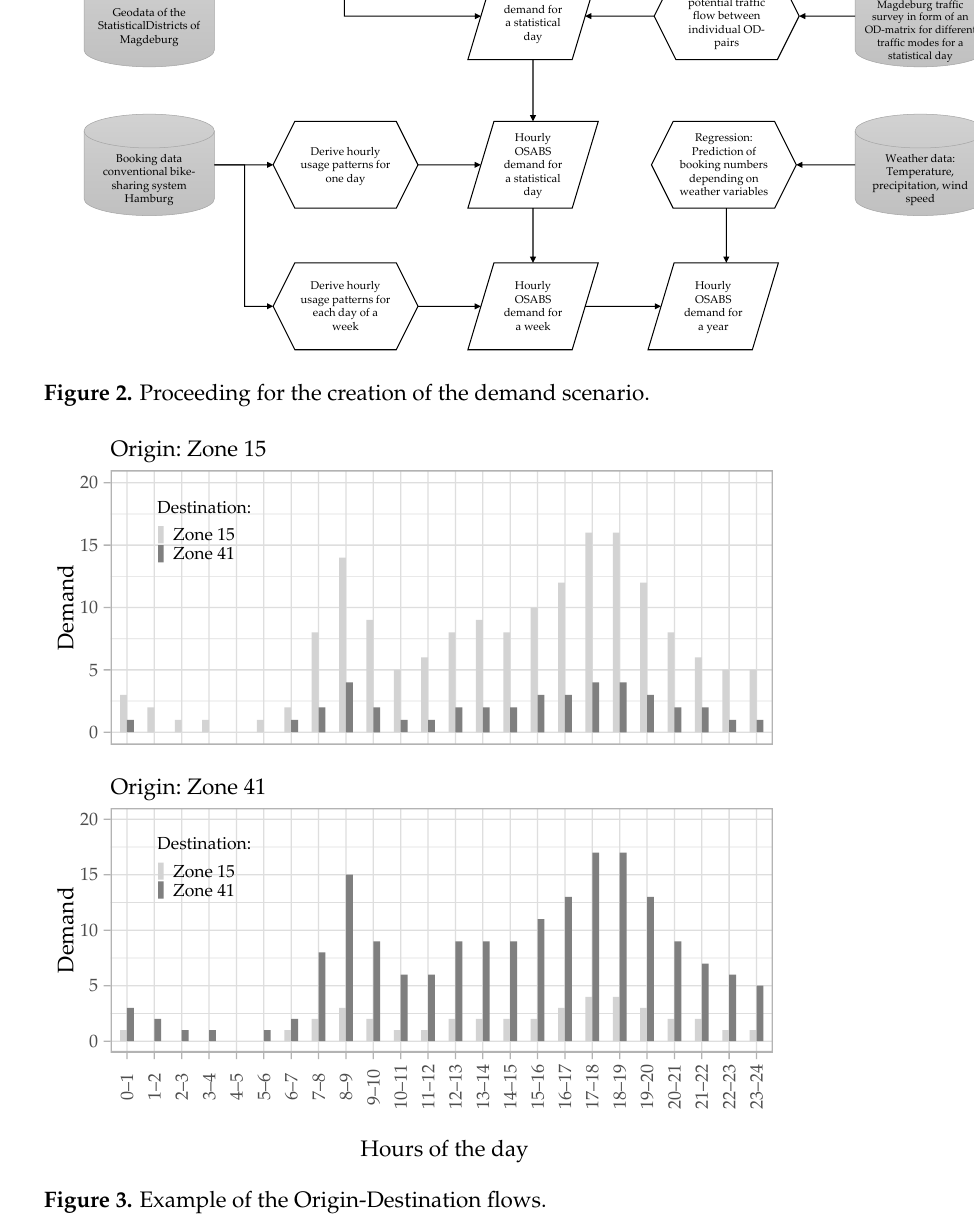
Figure 3. Example of the Origin-Destination